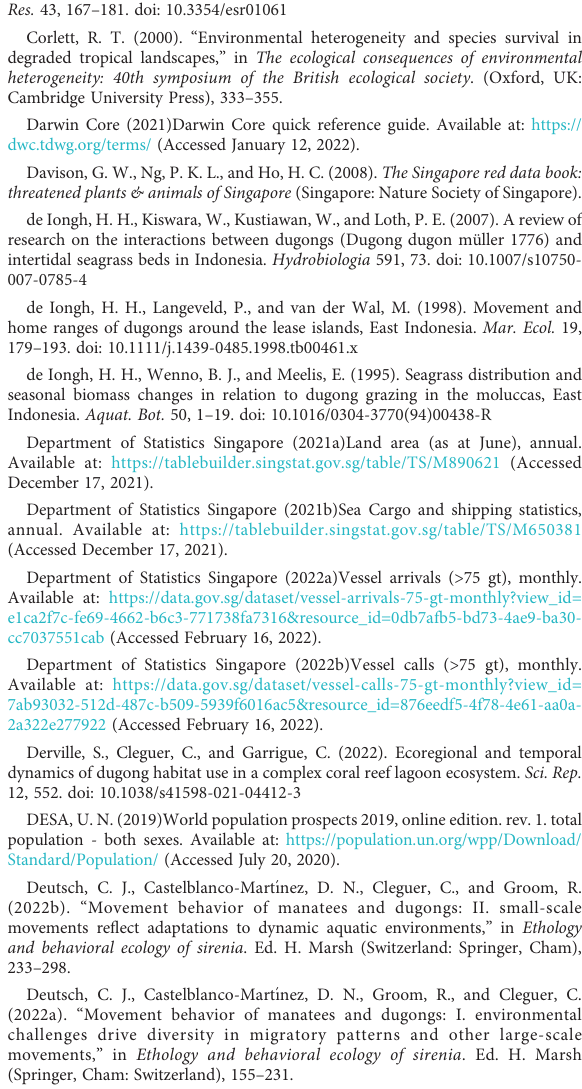
SUPPLEMENTARY FIGURE 2 Biometricinformation,a)length(n=26),b)weight(n=9),andc)sex(n=19),of dugong individuals as detailed in observation records between 1820 to 2021.